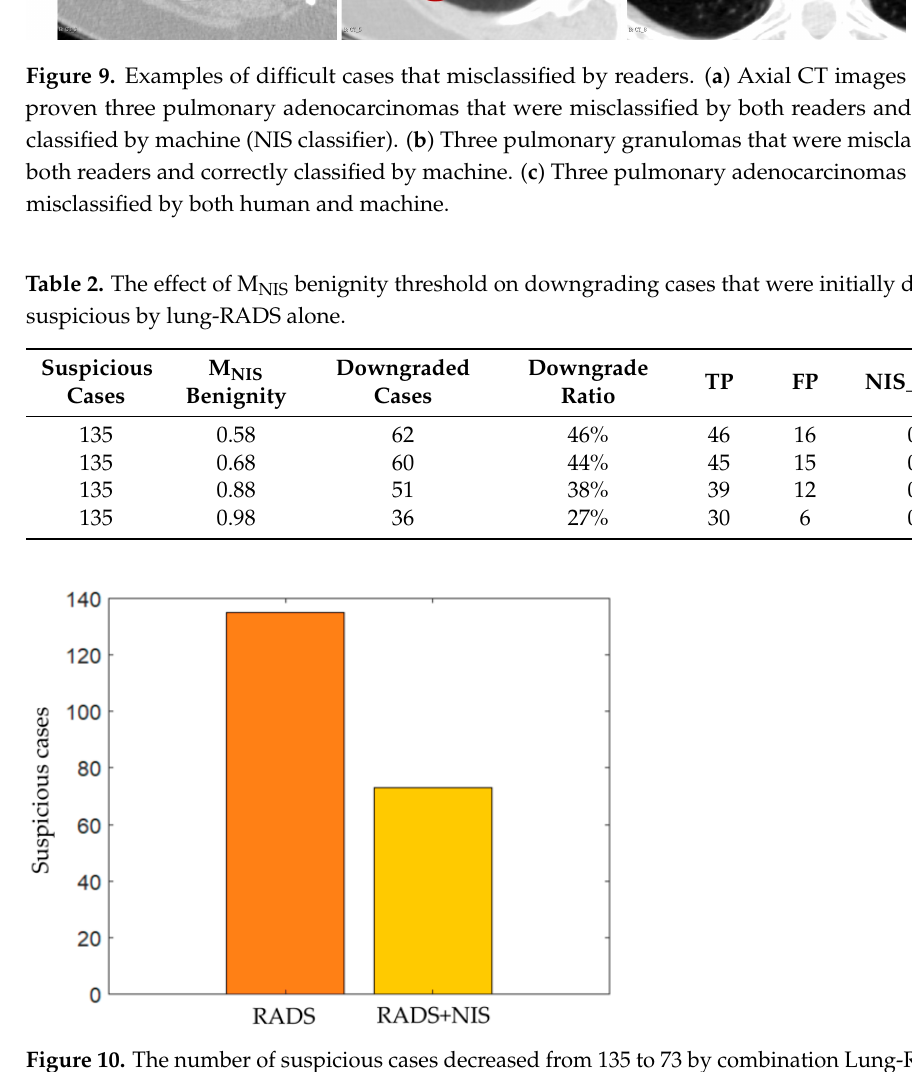
Figure 9. Examples of difficult cases that misclassified by readers. ( a ) Axial CT images of biopsy proven three pulmonary adenocarcinomas that were misclassified by both readers and correctly classified by machine (NIS classifier). ( b ) Three pulmonary granulomas that were misclassified by both readers and correctly classified by machine. ( c ) Three pulmonary adenocarcinomas that were misclassified by both human and machine.